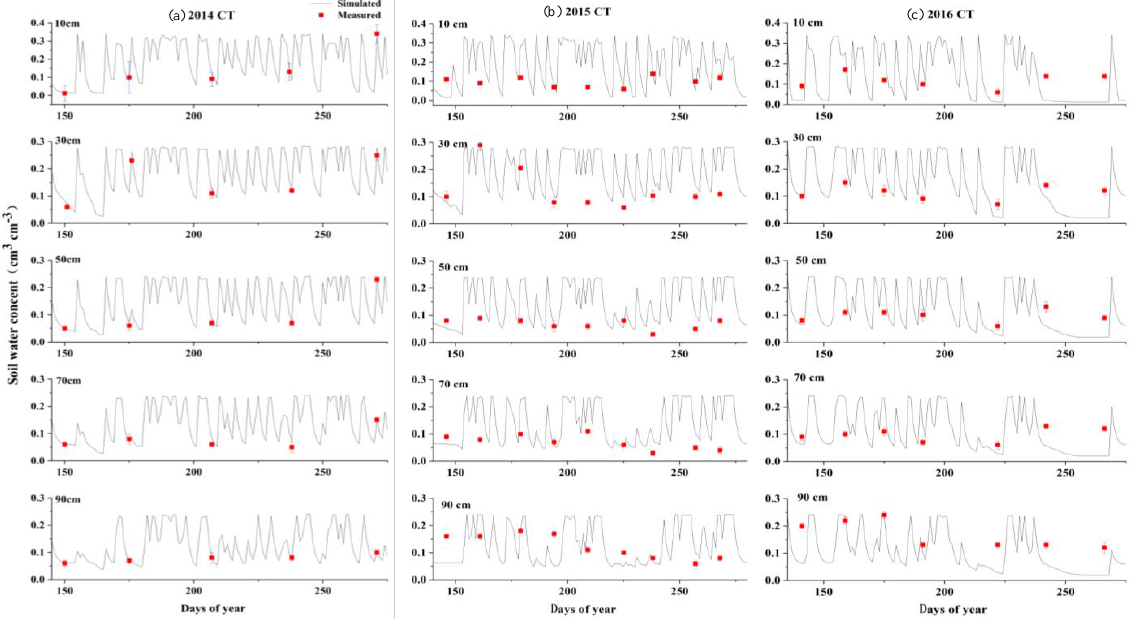
Figure 5. Measured and simulated soil water contents for CT at different soil depths during 2014‒2016.